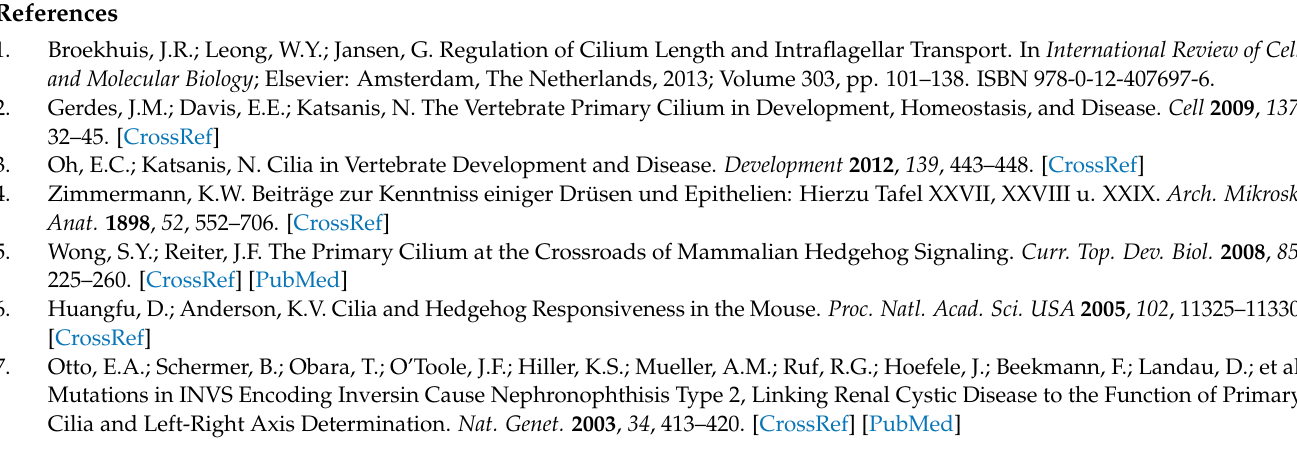
Figure S2: Confirmation of the presence of a primary cilium on DRG neurons, SG neurons and BCC with IFT88 staining; Figure S3: Boundary Cap Cells (BCC) carried a primary cilium at HH30, both in dorsal and ventral roots; Figure S4: Melanocytes possessed a primary cilium in